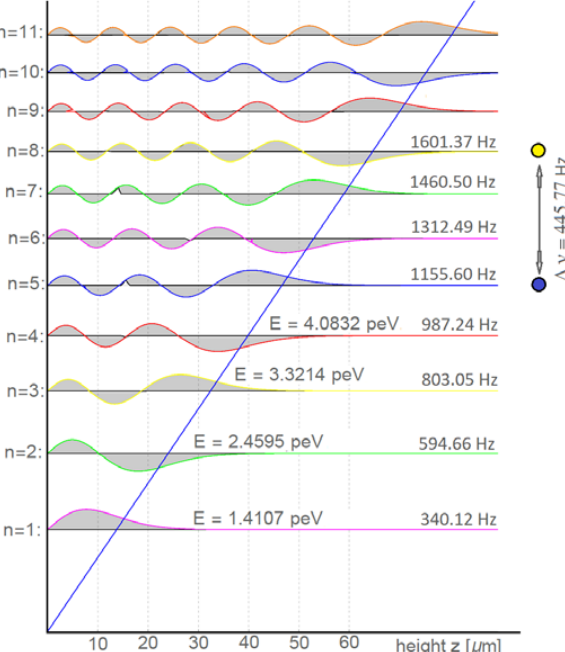
Figure 6. Energy eigenvalues and eigenfunctions of a neutron bound in the gravity potential of the Earth and corresponding frequency equivalents. By oscillating the mirror with a frequency, which correspond to the energy difference between quantum states, transitions are introduced. The oscillation frequencies are in the acoustic frequency range.